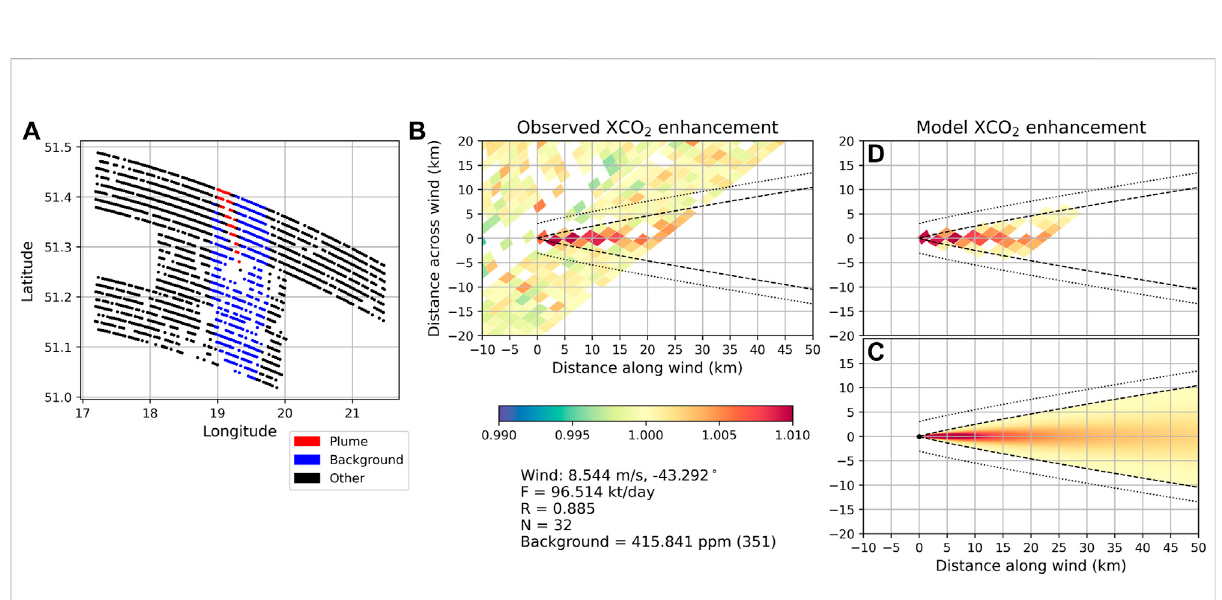
FIGURE 8 Same as Figure 4 for OCO-3 Be ł chat ό w SAM on 2022-06-24. The higher number of missing footprints (evident in panels (A,B) ) compared with other SAMs is due to application of data quality fi ltering. Although the observed (panel (B) ) and model (panel (D) ) enhancements match very well, estimated emissions are somewhat higher than expected, even following improvements by applying standard OCO-3 data quality fi lters.